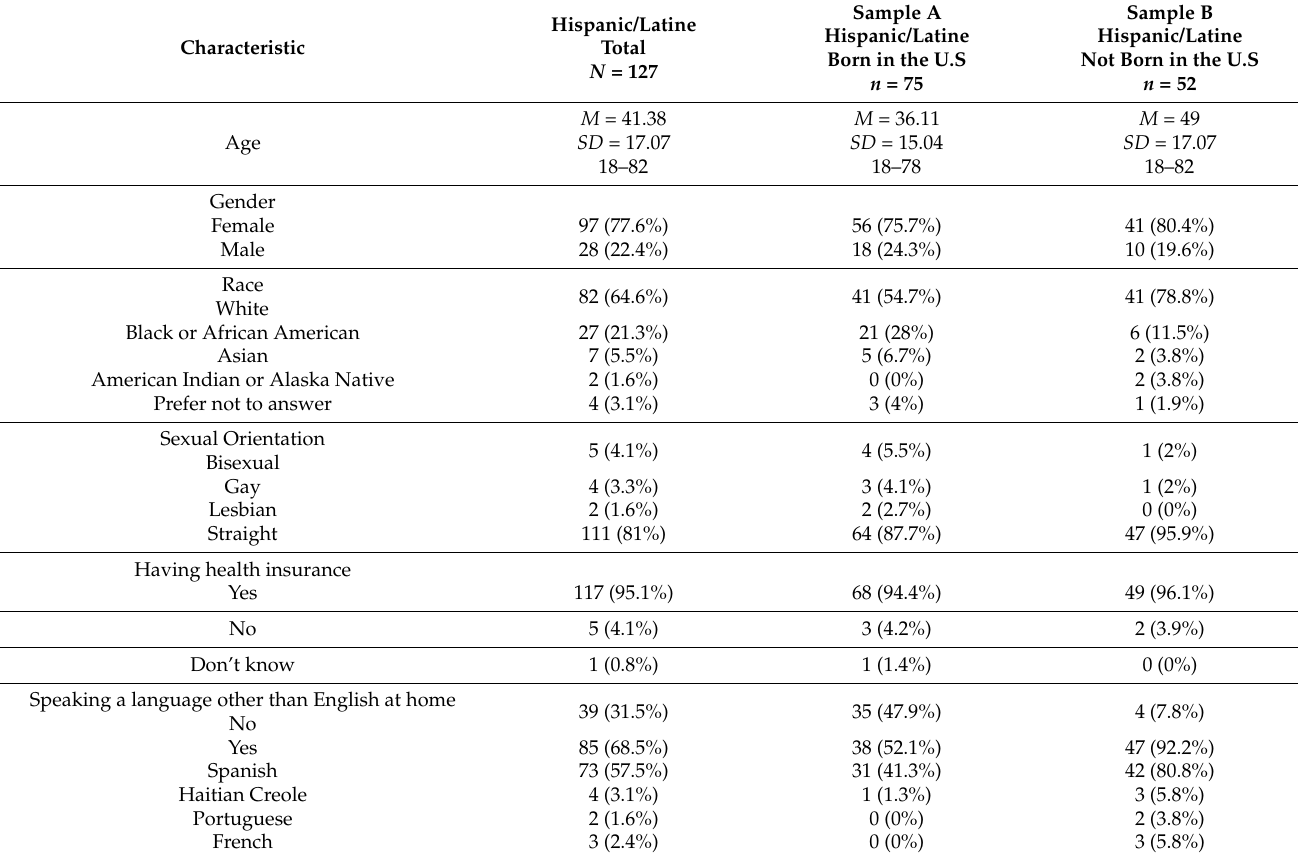
Table 1. Demographic Characteristics of Survey Respondents: overall and by